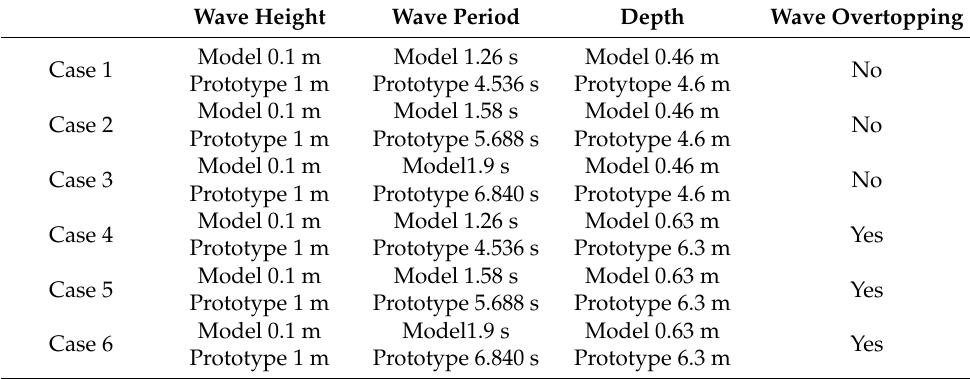
Table 1. Experimental